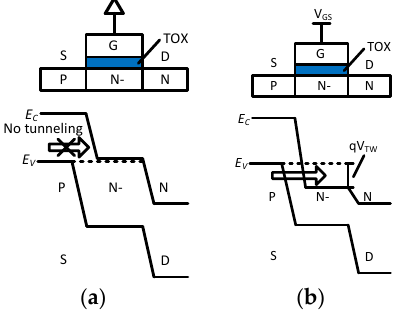
Figure 14. ( a ) Tunnel field effect transistor (TFET) in the cutoff mode; ( b ) TFET is turning on.